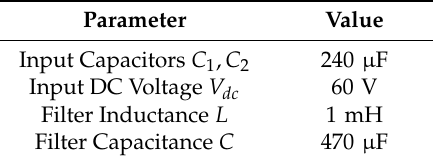
Table 3. Experimental parameters.